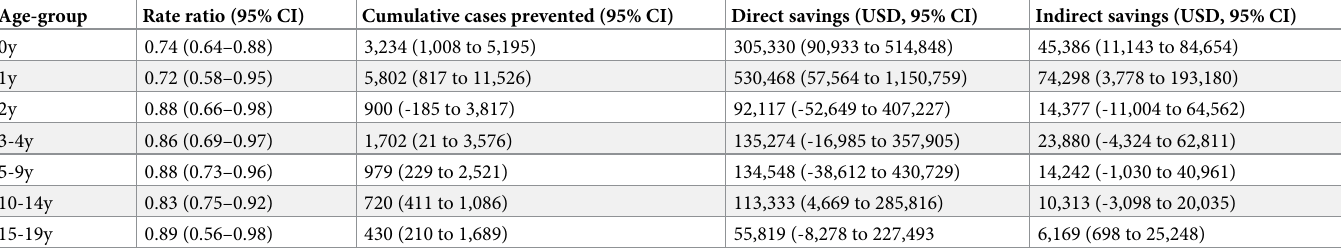
Table 3. The rate ratio between observed and predicted primary care visits due to Acute Otitis Media (AOM) and complications during the post-vaccine period